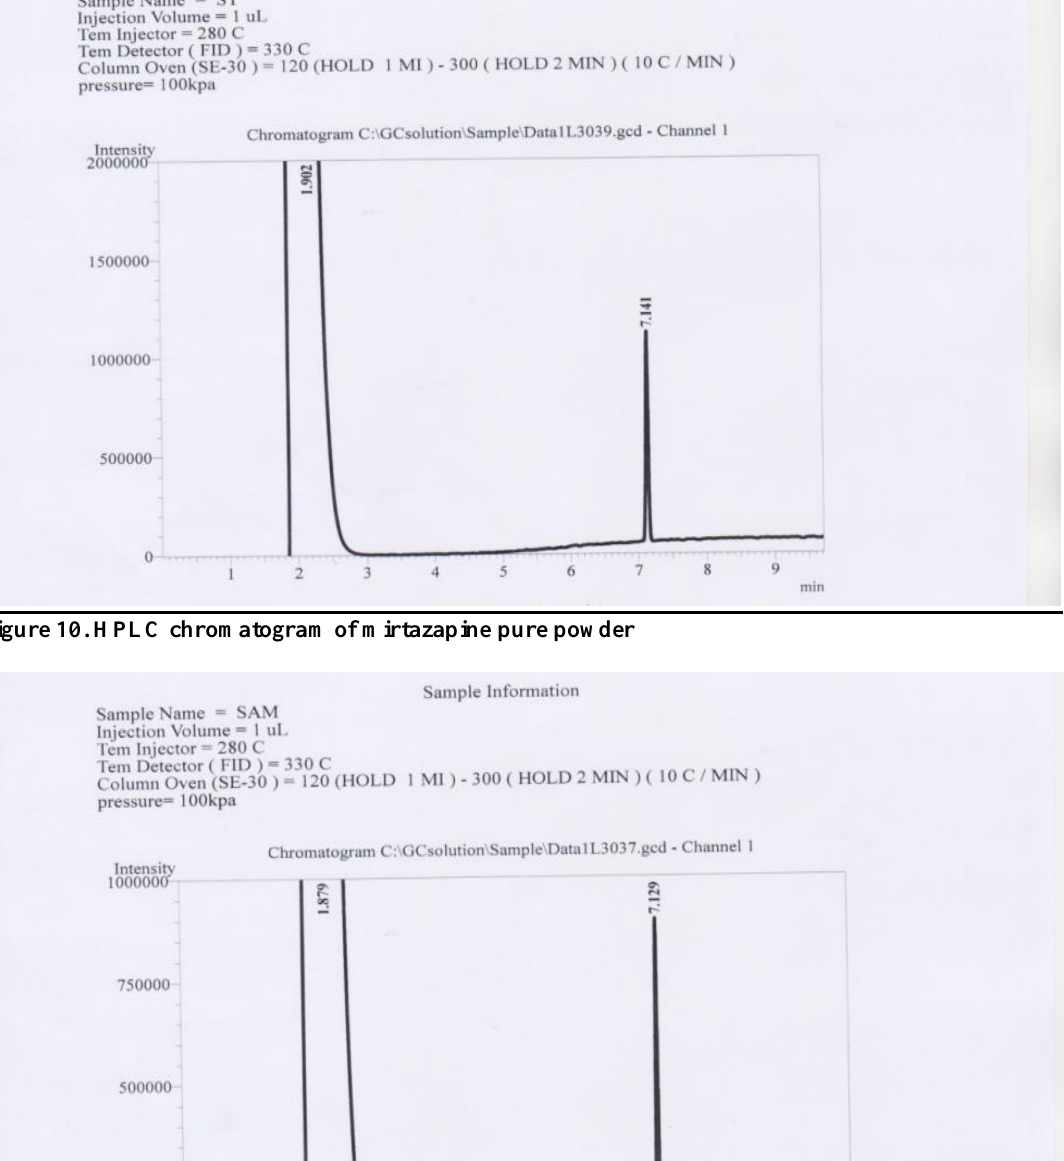
Evaluation of surface